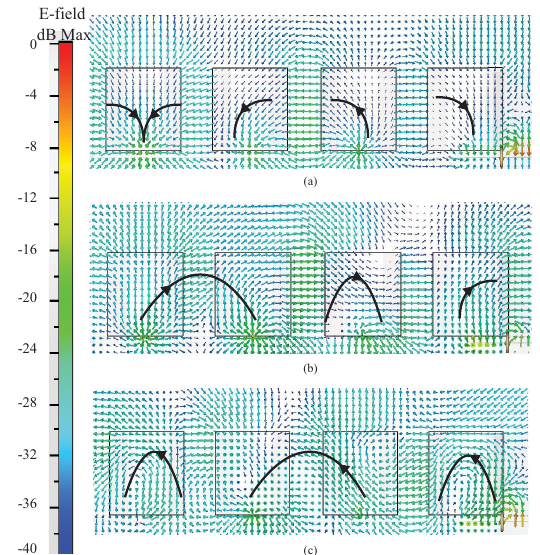
FIGURE 6: E-field distribution at: (a) 1.52 GHz (b) 3.12 GHz and (c) 4.25 GHz.